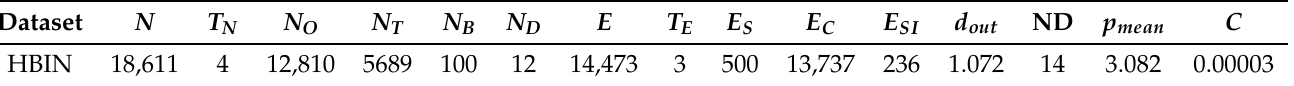
Table 2. Network attributes of HBIN constructed by the dealt data used in the